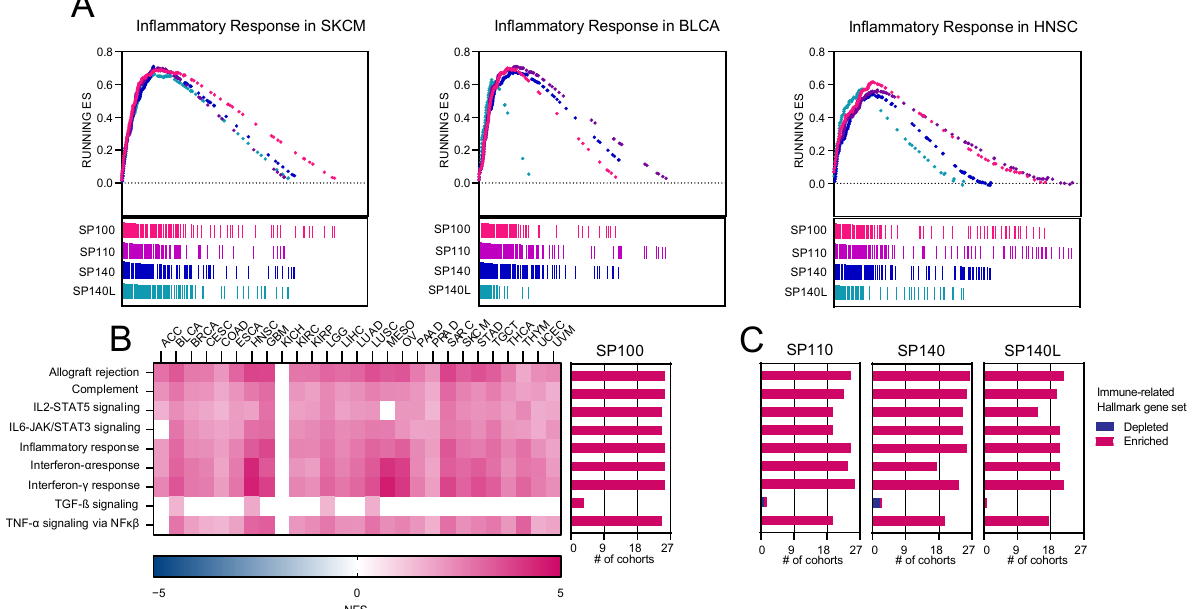
Figure 3. Stemness signature enrichment in the transcriptome profiles associated with the expression of SP family members ( SP100 , SP110 , SP140 , and SP140L ). For AIRE and ATAD2-associated transcriptome profiles, the gene-set-size threshold was not passed during the GSEA. The GSEA was performed by using significantly differentially expressed genes ( p < 0.05, FDR < 0.05) in TCGA patients divided into low-expressing or high-expressing BrD cohorts (using the mean expression of each gene as a cutoff). ( A ) The enrichment plots of Inflammatory Response Hallmark term in transcriptome profiles associated with SP100 , SP110 , SP140 , and SP140L in SKCM, BLCA and HNSC. Gene ranks for SP100 (magenta), SP110 (purple), SP140 (blue), and SP140L (green) associated transcriptome profiles are presented at the bottom of the enrichment plots. ( B ) The heatmap of NES of immune-related Hallmark gene sets among 26 solid tumor types for SP100 with a summarized number of cohorts. Color of the heatmap denotes either increase (magenta) or decrease (dark blue) of NES. # of cohorts – the number of TCGA cohorts with either positive (magenta) or negative (dark blue) association with immune-related Hallmark terms in high-expressing BrD groups. ( C ) Summarized number (#) of cohorts with either increased (magenta) or decreased (dark blue) NES of immune-related Hallmark gene sets for SP110 , SP140 , and SP140L